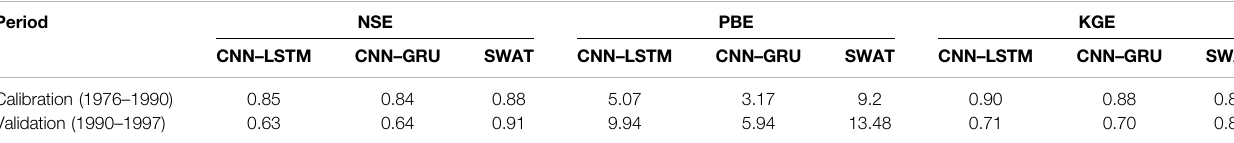
TABLE 4 | Comparison of prediction performances in deep learning models and hydrological model.